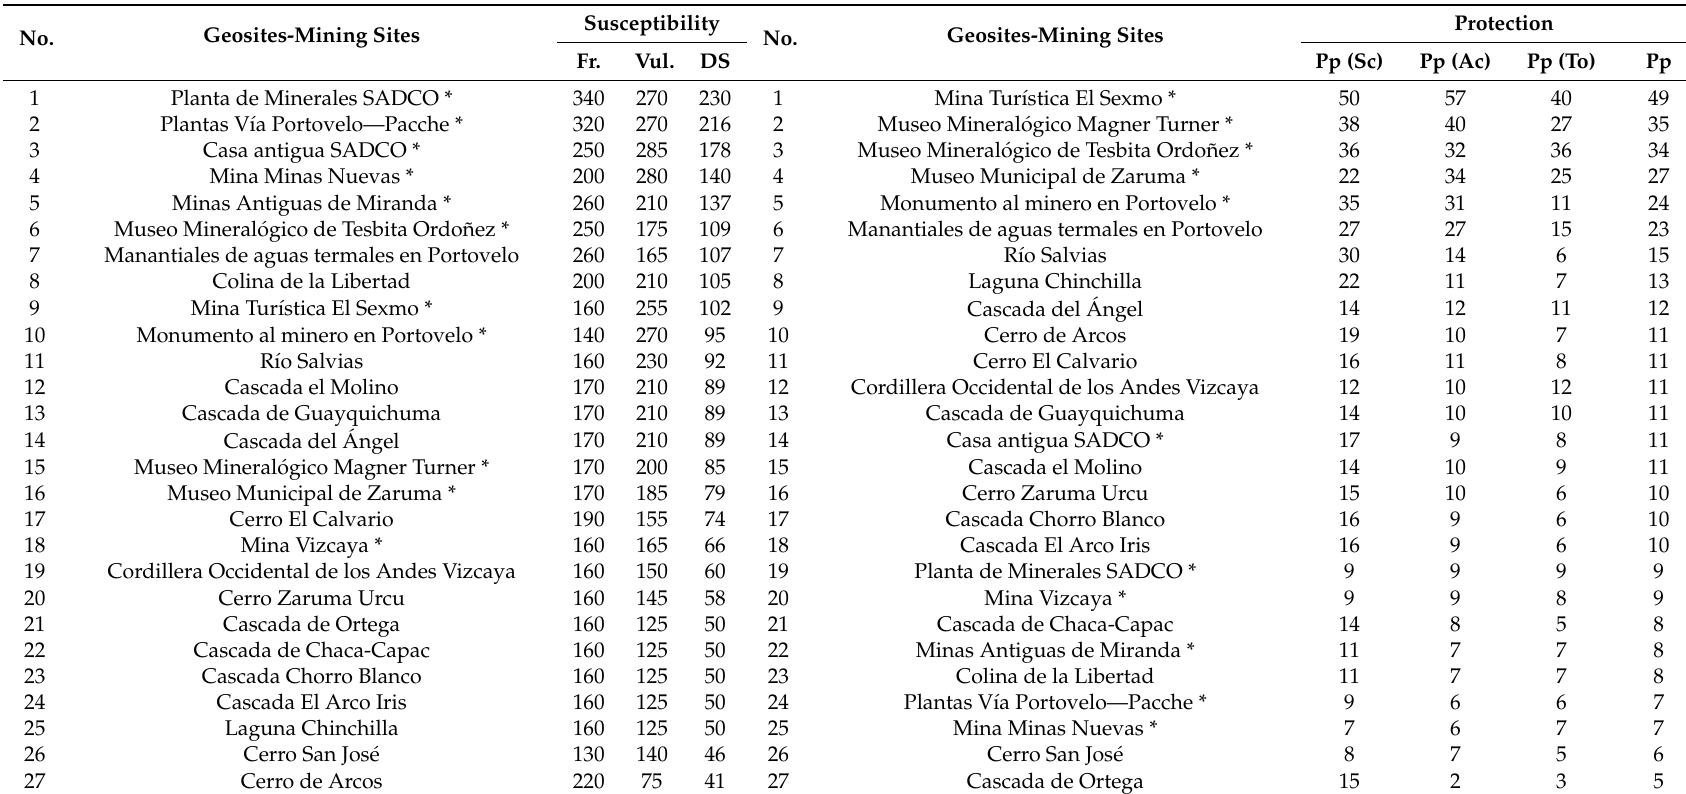
Table 5. Susceptibility and Protection Priority assessment of the geosites and mining sites (*). Fragility (Fr.), Vulnerability (Vul.), Degradation Susceptibility (DS), Protection Priority